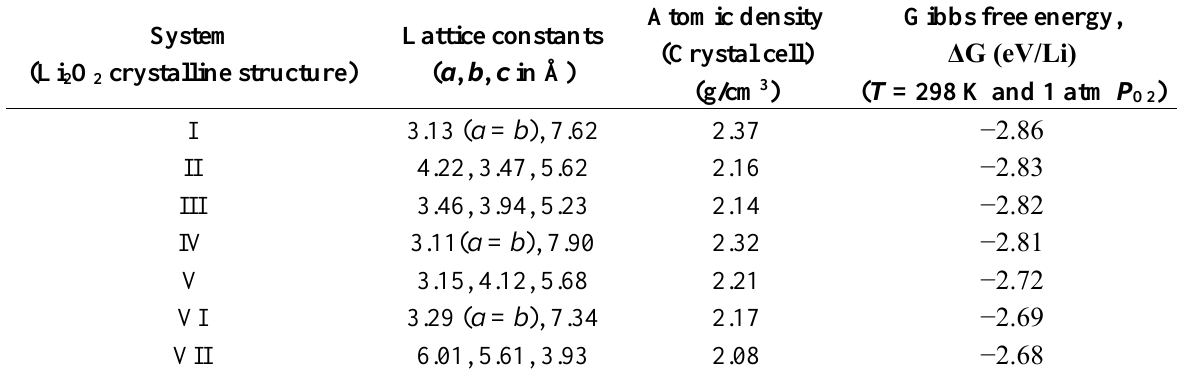
thermodynamic stable crystalline structures of Li 2 O 2 solids shown in Figure